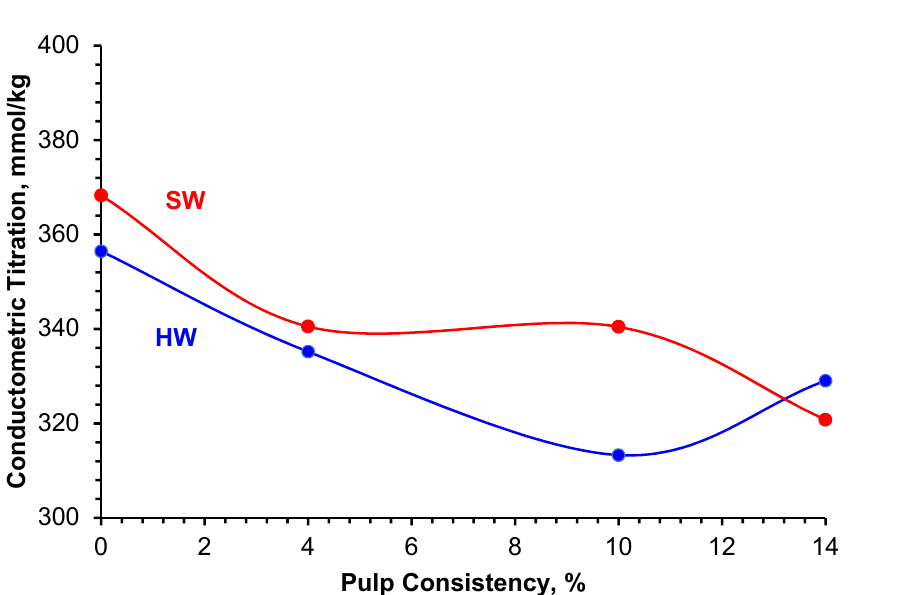
Figure 4. Effect of oxidation on the sulfate half ester content on HW and SW derived CNC by con-